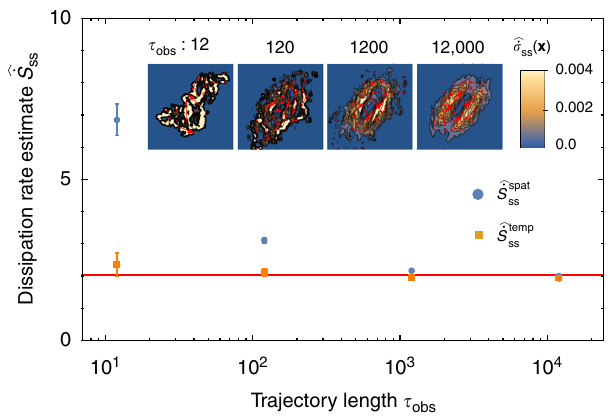
Fig. 2 Convergence of dissipation estimates. The spatial (blue solid circles) and temporal (red solid squares) dissipation rate estimates converge to the steady-state value _ S (red line) of Eq. (7). Estimates of the total dissipation ss rate, calculated from Eqs. (12) and (13), are extracted from Langevin trajectories simulated for time τ obs with timestep 10 − 3 using k = γ = 1, k T = 25, and k T = 250 as in Fig. 1. Error bars are the standard error of B c B h the mean, computed from 10 independent trajectories. Estimates of the local dissipation rate from the spatial estimator with different trajectory lengths are plotted in the